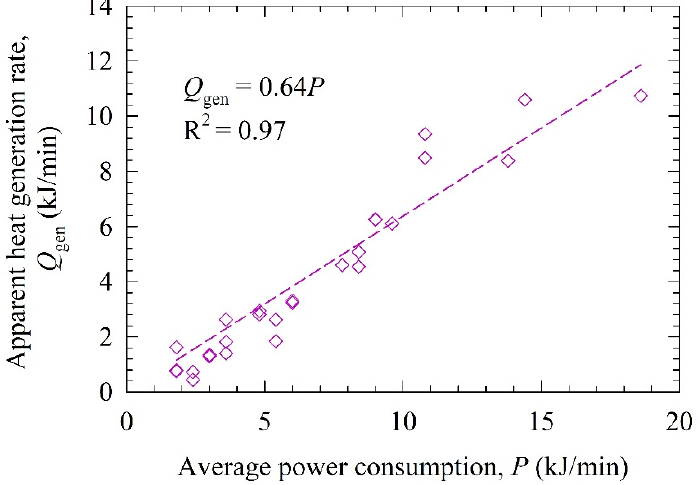
Figure 1. Correlation between apparent heat generation rate Q gen and power consumption P